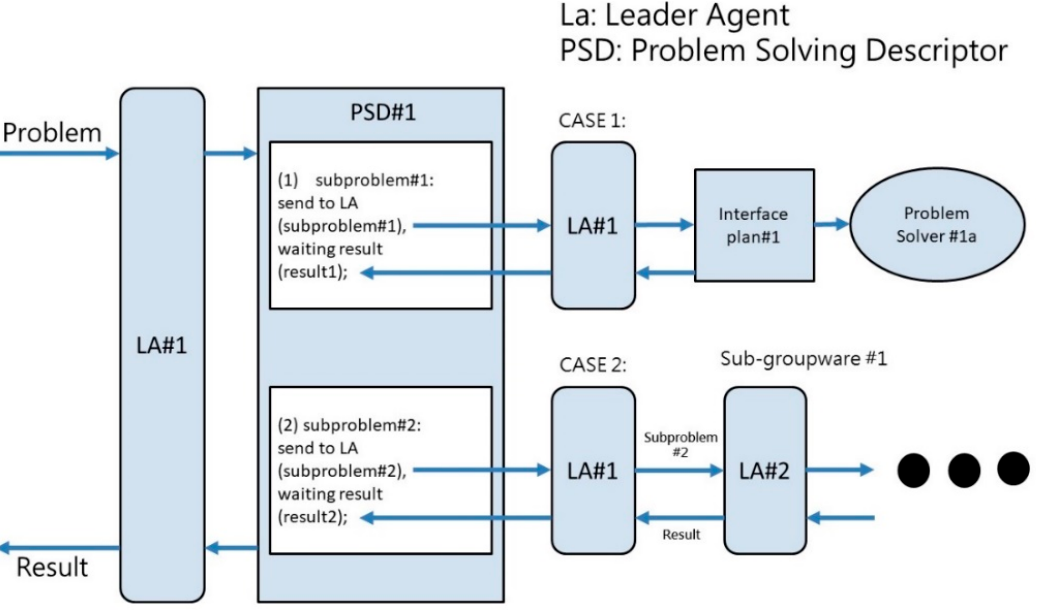
Figure 5. Schematic diagram of OOCDPSS [27].